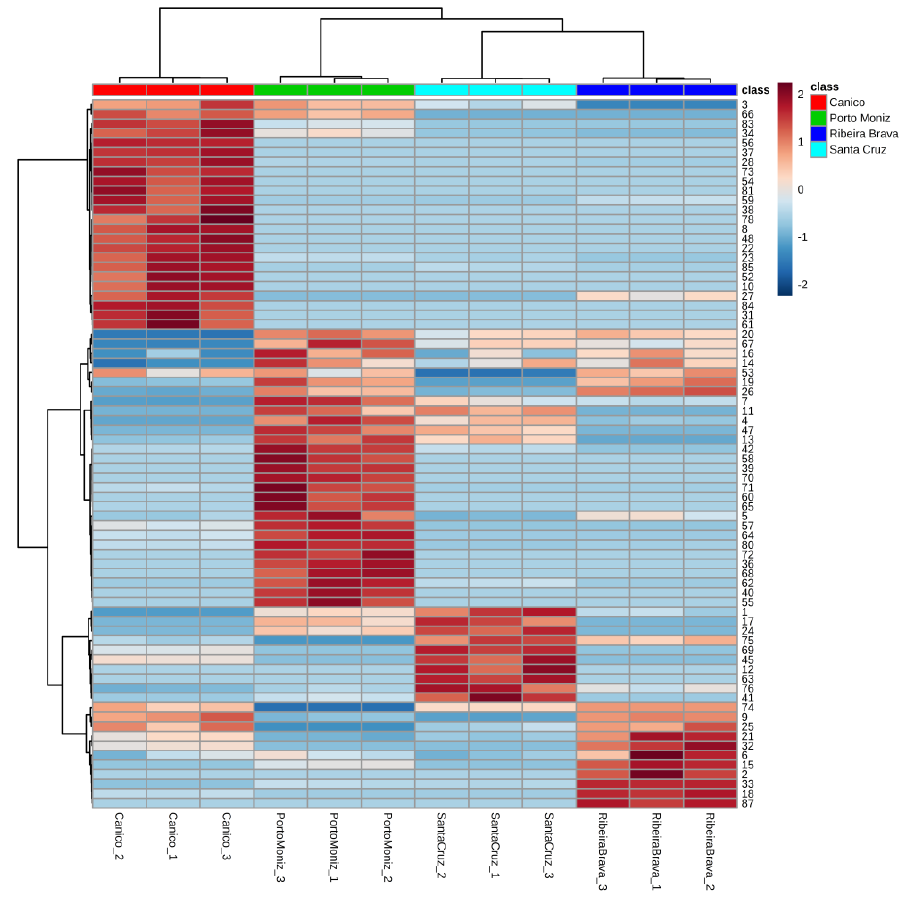
Figure 4. Clustering result in the form of a heatmap.